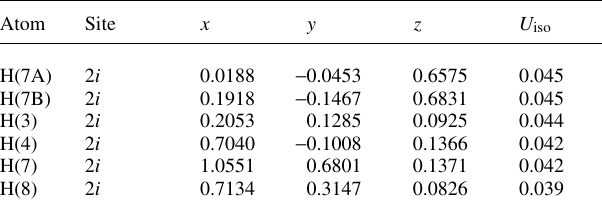
Table 2. Atomic coordinates and displacement parameters (in Å 2 )